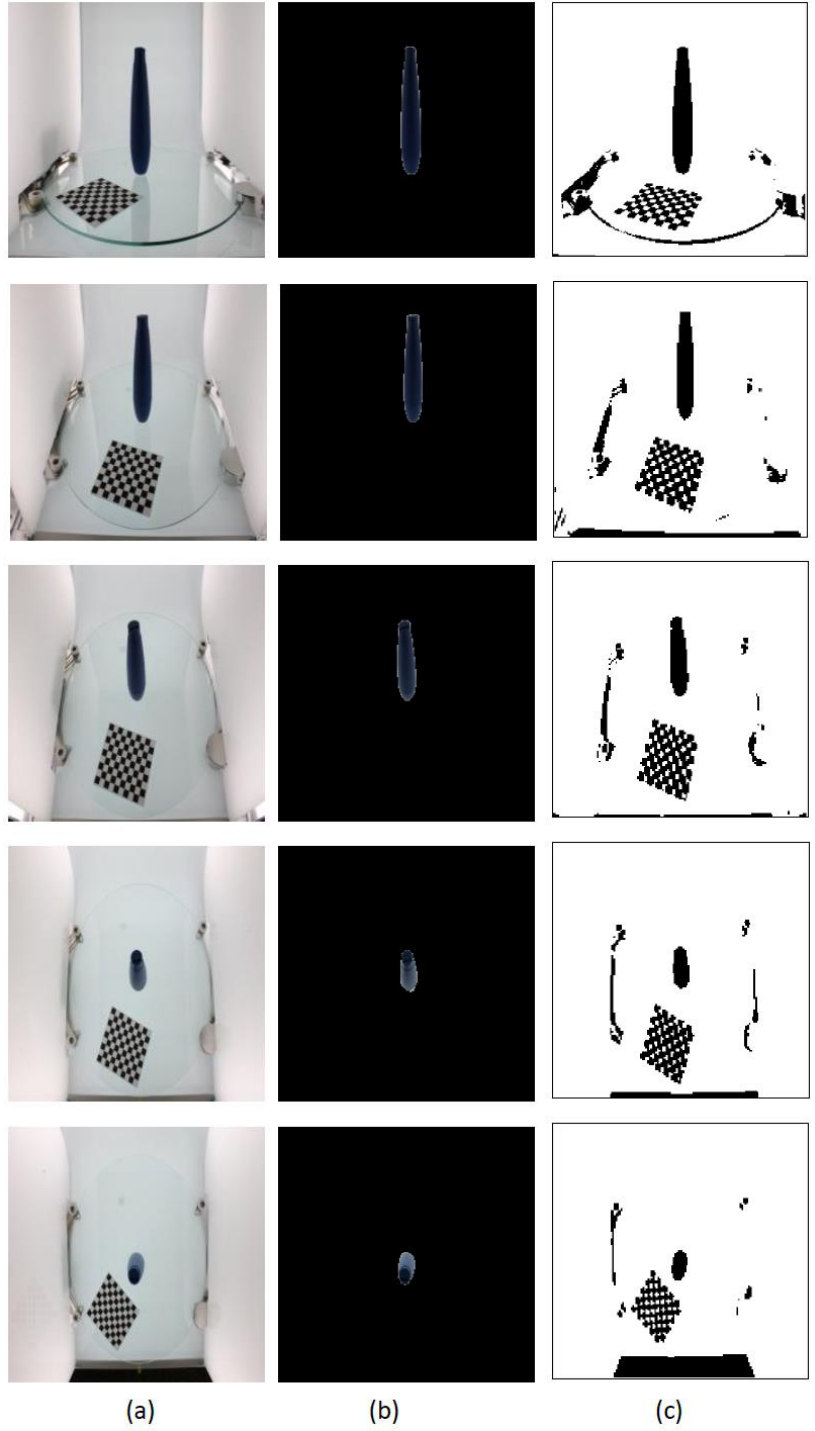
Figure 7. GrabCut-based segmentation experiment results for ikea_table_leg_blue object: ( a ) input image after resizing; ( b ) GrabCut method segmentation results; ( c ) Otsu method segmentation results.